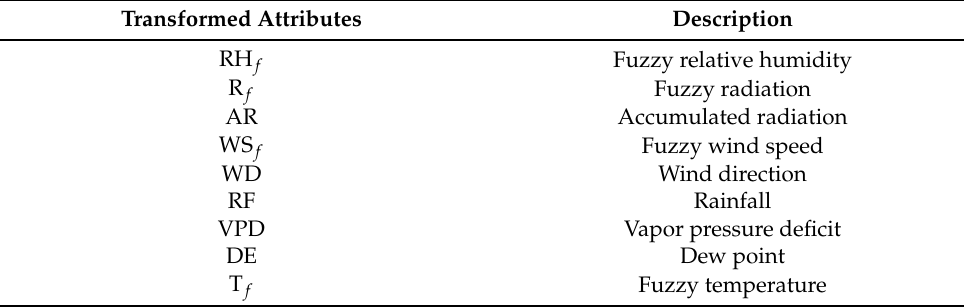
Table 2. Fuzzy transformation of